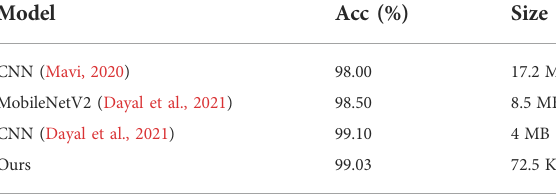
TABLE 2 Comparisons with state-of-the-art